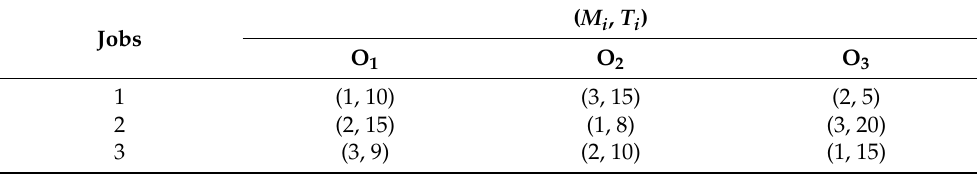
Figure 1. SOI-based encoding mapping. Table 3. A case of JSSP [36].